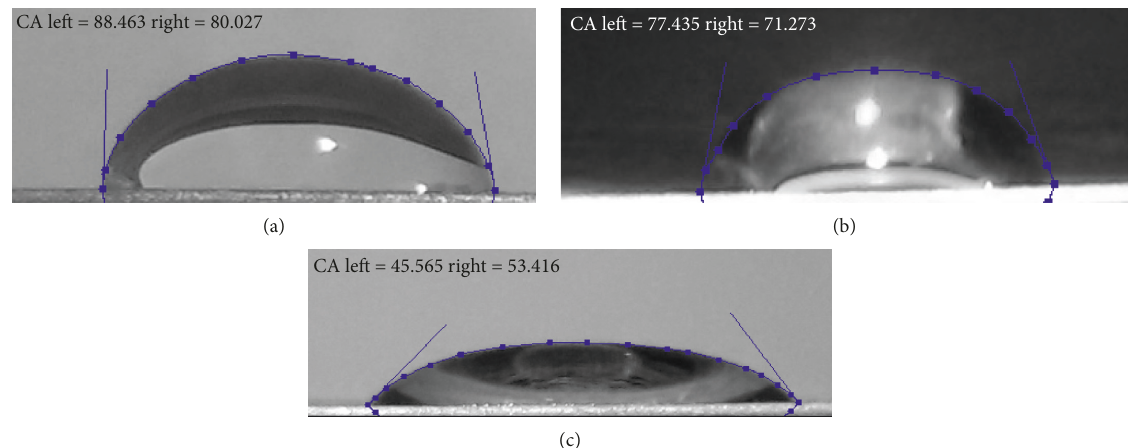
Figure 3: Static contact angles of pure water on stainless steel plates for (a) clean surface and (b) 20 minutes and (c) 60 minutes EPD coating. CA left = 24.683 right = 40.335 CA left = 37.452 right = 43.038